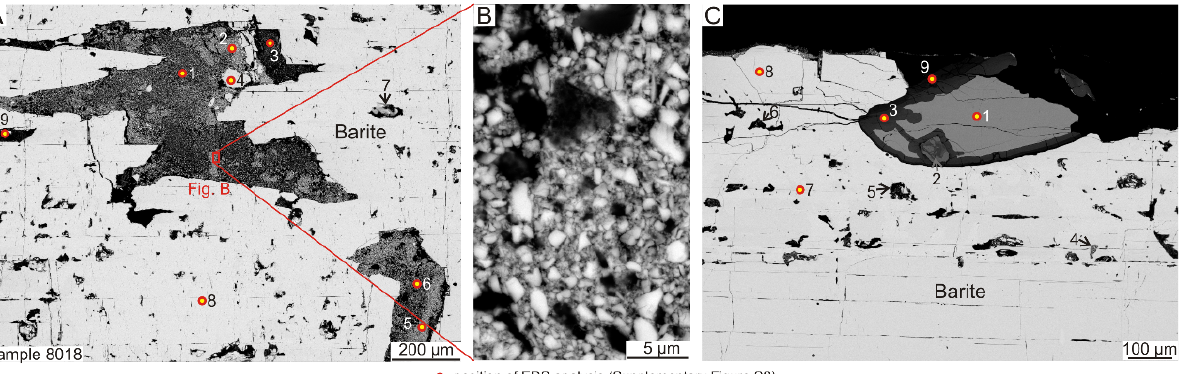
Figure 7. BSE images of cataclastic barite, chalcopyrite and pyrite in sample 8018. ( A ) Barite with fragmental (cataclastic) texture (1–4, 5–6) and cations in various combinations (Si, Al, Mg, Ca) plus Cl. ( B ) Zoom showing barite fragments with varying combinations of cations. ( C ) Barite engulfing chalcopyrite and pyrite (1, 2) with alteration halo made up of cuprite and limonite (3, 9). Fluid inclusions (5, 6) each show a strong alignment (horizontal in the image).